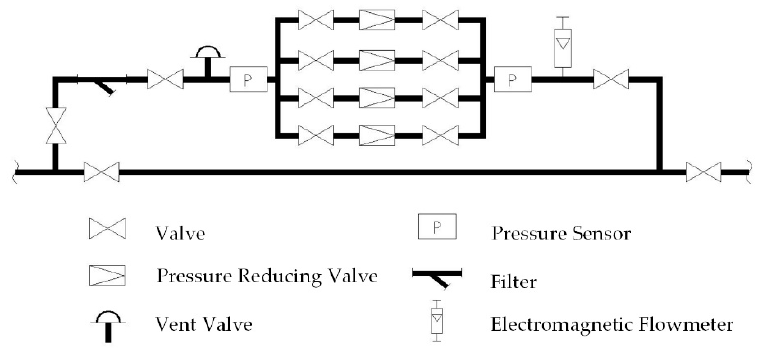
Figure 3. Pressure-regulating device scheme .